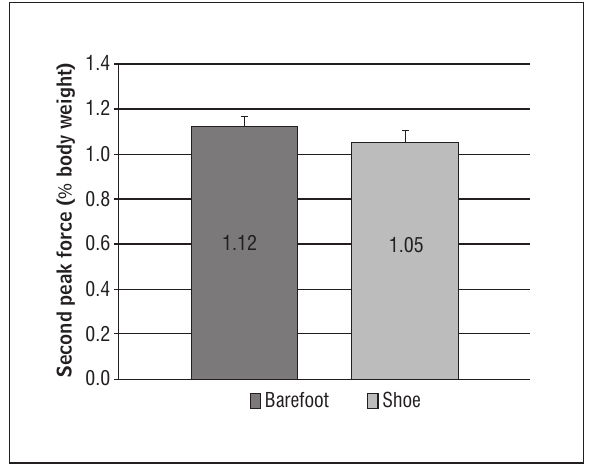
Figure 4 - Second peak force for barefoot and footwear